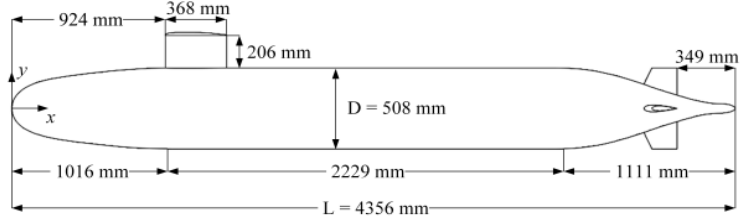
Figure 1. The shape of the SUBOFF.